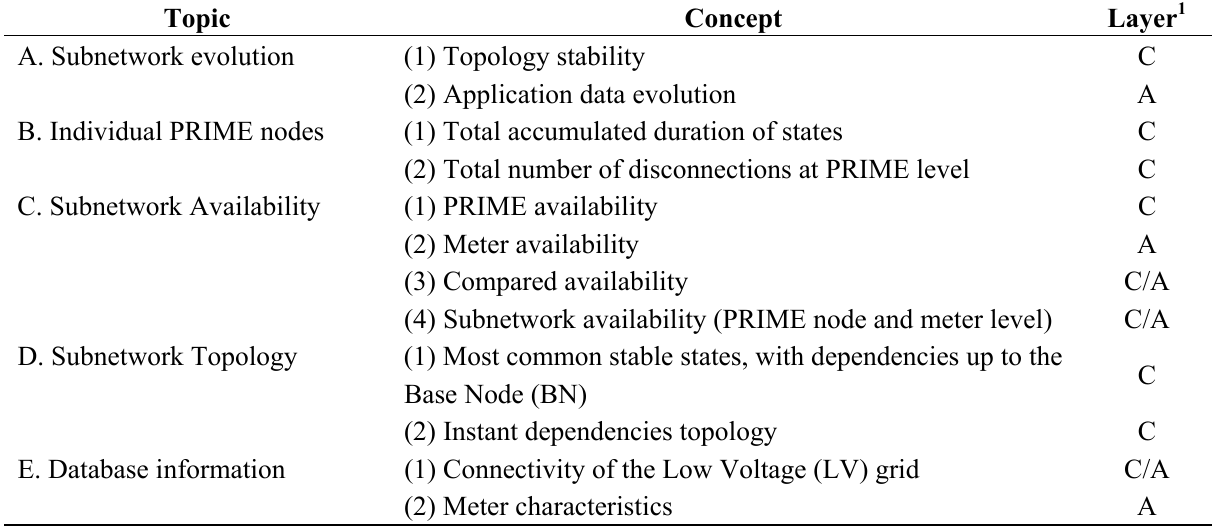
Table 3. Concepts needed for Smart Metering PLC networks analysis.